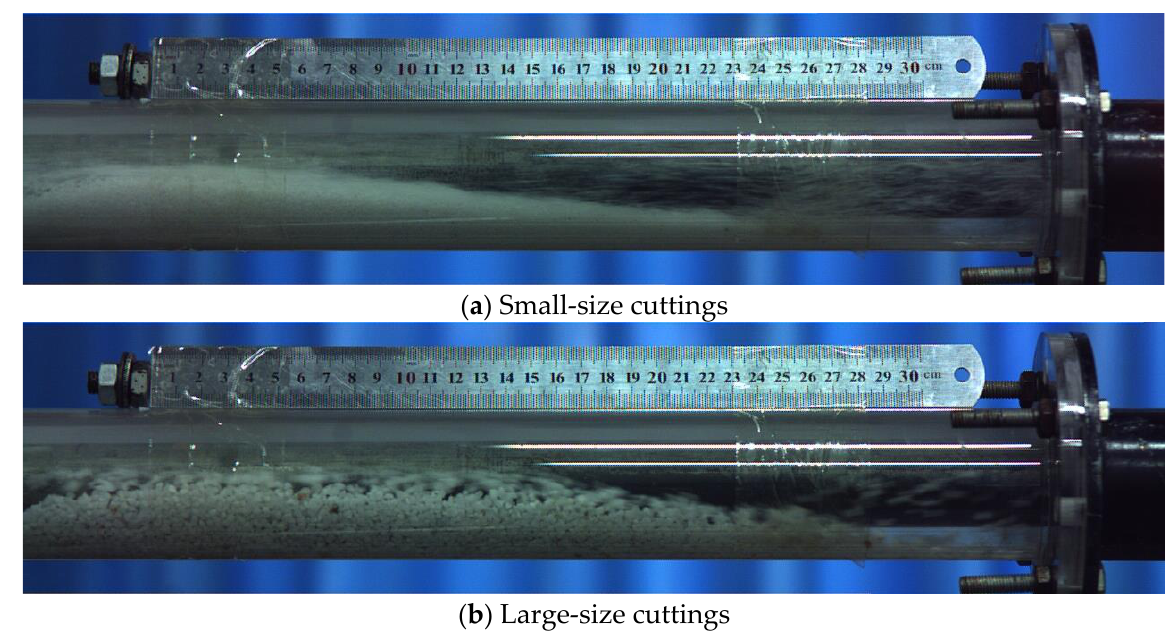
Figure 4. Cuttings transport experiment for cuttings with different sizes. Table 2. Test matrix for cuttings transport experiments.